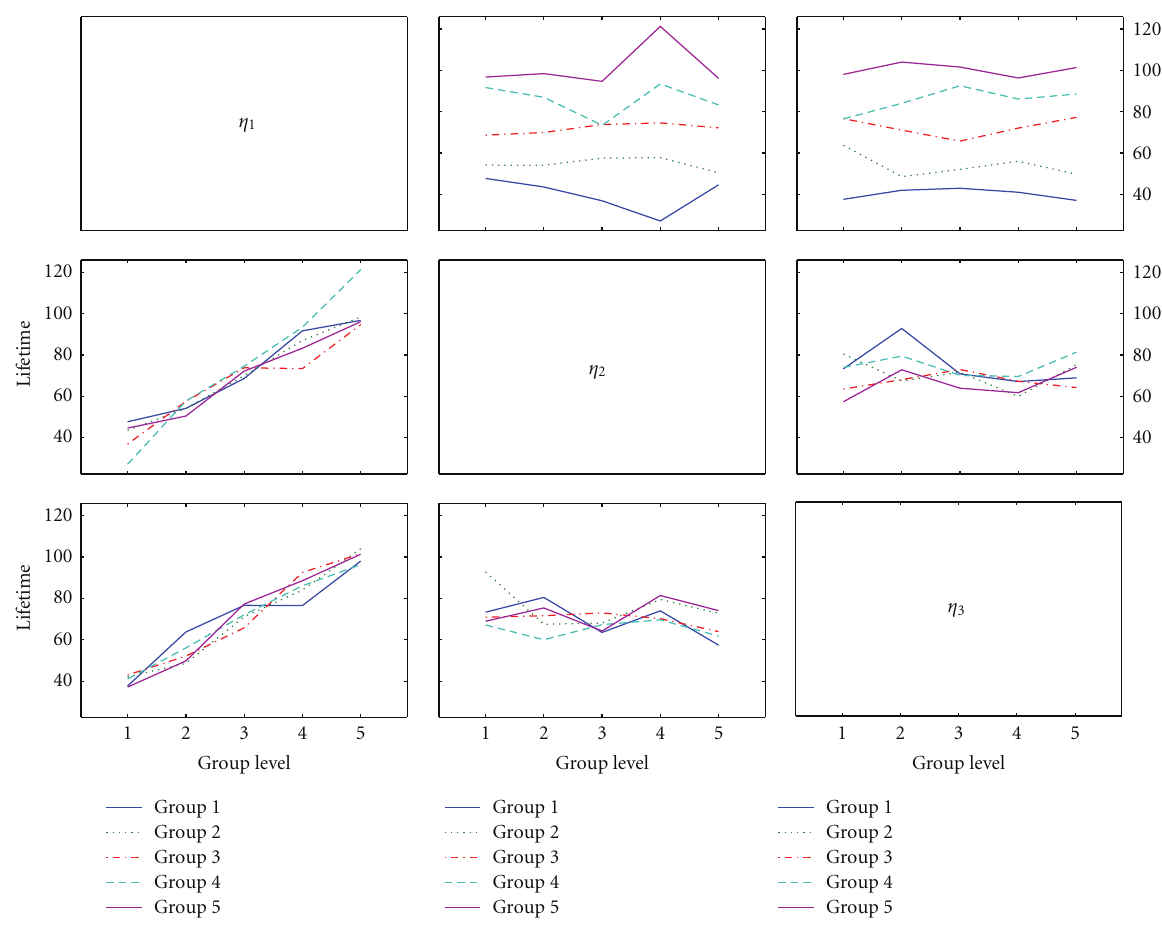
Figure 9: Interaction across all